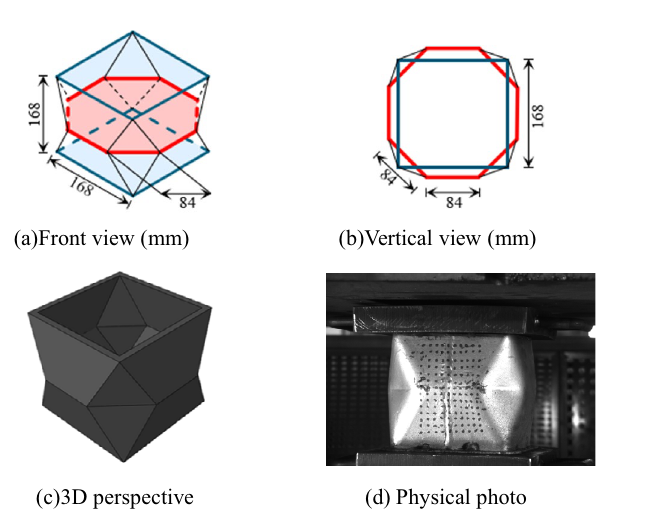
Figure 3. Dimensions of the pre folded energy-absorbing device.